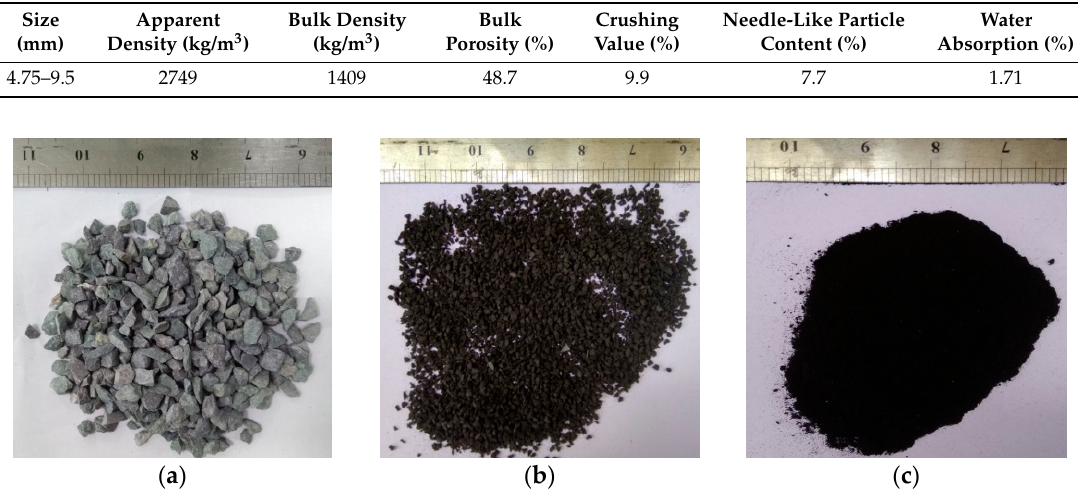
Figure 1. Coarse aggregate and crumb rubbers: ( a ) coarse aggregate, ( b ) coarse crumb rubber, and ( c ) fine crumb rubber.